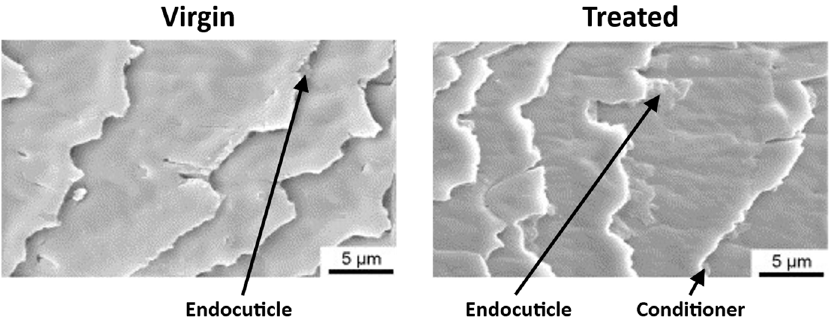
Figure 6. SEM images of virgin and treated hair. Adapted from reference [23] with permission from Elsevier.